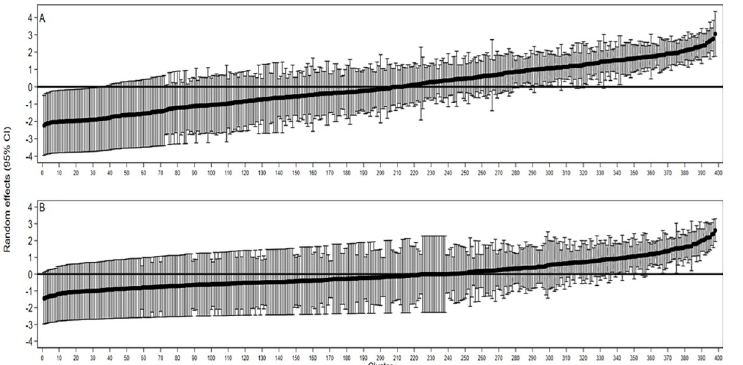
Fig 1. Cluster level differences in A) Knowledge level and B)